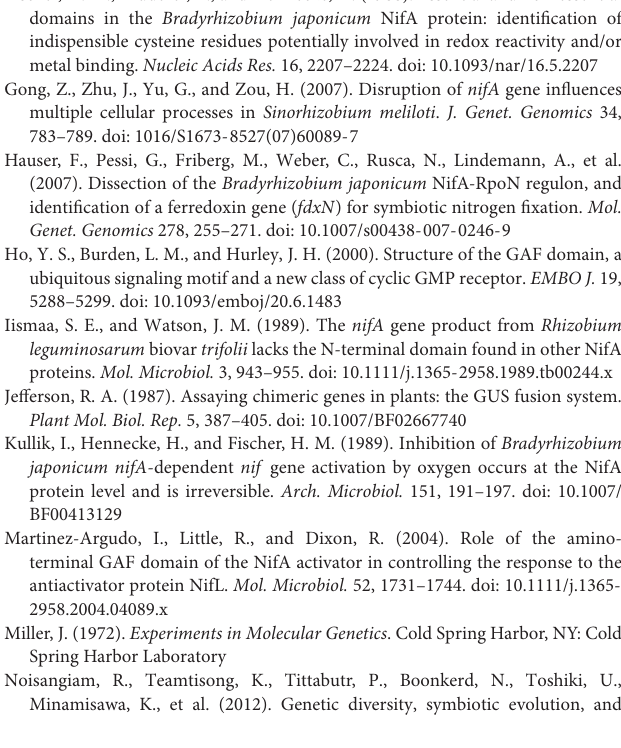
FIGURE S1 | The two nifA genes in Bradyrhizobium sp. DOA9 strain are functionally redundant during symbiosis with Aeschynomene americana . (A) Comparison of plant growth (aerial part) non-inoculated (NI) or inoculated with WT and insertion mutant strains DOA9 (cid:127) nifAc and DOA9 (cid:127) nifAp (at 20 dpi). (B–D) Root nodules observed with a fluorescent stereomicroscope equipped with a green fluorescent protein (GFP) filter. (B) Nodules elicited by WT; (C) Nodules elicited by DOA9 (cid:127) nifAc ; (D) Nodules elicited by DOA9 (cid:127) nifAp. (E) Acetylene-reducing activity (ARA) in A. americana plants inoculated with WT and insertion mutant strains DOA9 (cid:127) nifAc and DOA9 (cid:127) nifAp . (F) Number of nodules per plant elicited by WT and DOA9 (cid:127) nifAc and DOA9 (cid:127) nifAp. (G-I) Cross section of nodule elicited by WT (G) and mutants DOA9 (cid:127) nifAc (H) and DOA9 (cid:127) nifAp (I) . Scale bars are 250 µ m for (D–G) . In (E,F) , error bars represent standard error ( n = 10). Different letters above error bars indicate significant differences at P < 0.05 (Tukey’s HSD test). FIGURE S2 | Bradyrhizobium sp. strain DOA9 strain displays two distinct nifA genes. (A) Sequence alignment of NifAc and NifAp. Arrows and boxes indicate different portions of NifAp and NifAc used to form chimeric NifA proteins (B) . The color boxes indicate NifAc protein domains including GAF (blue), sigma factor 54 ( δ 54 ) interaction (purple), and HTH (green) domains. (B) Schematic representation of different versions of nifA introduced into plasmid pMG103- npt2-cefo under control of the constitutive nptll promoter. Each constructed plasmid was transferred into DOA9 (cid:49) nifAc cells for complementation experiments (see Table 1 ). TABLE S1 | Primers used in this study. TABLE S2 | Primers used in the qRT-PCR experiment. TEXT S1 | Analysis of Insertion sequences in the nifAp surrounding